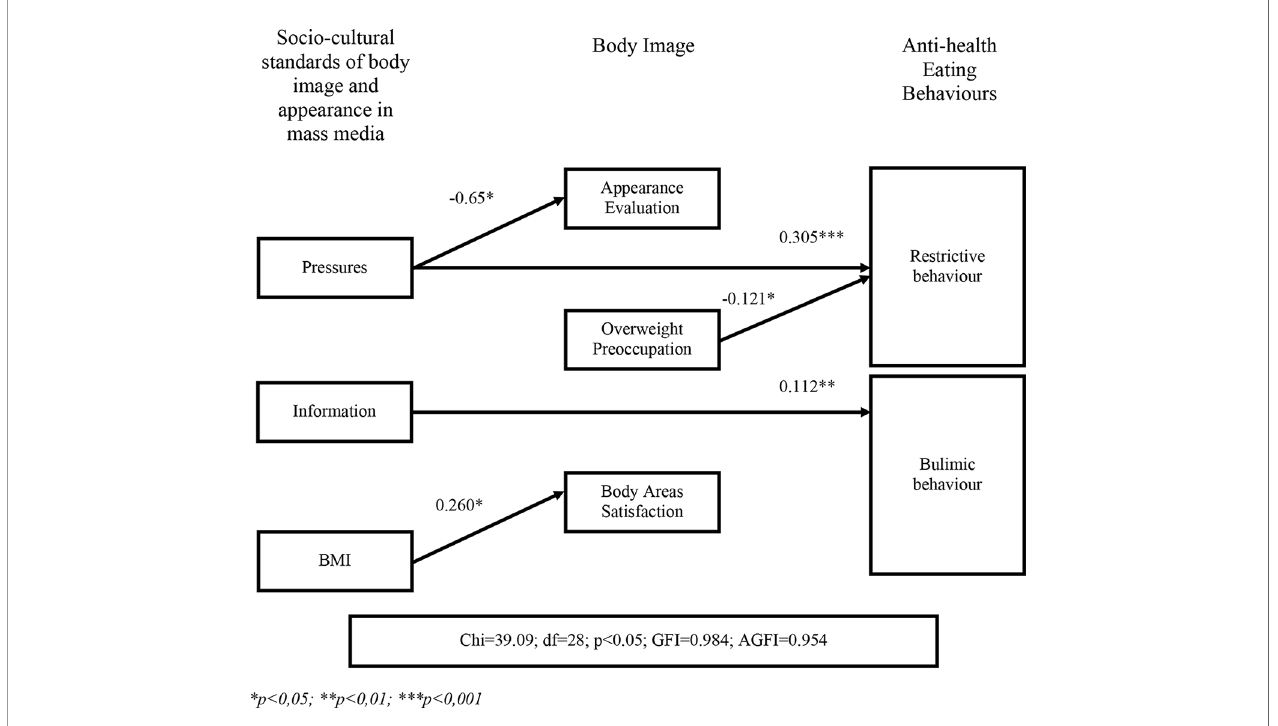
FIGURE 2 | Analysis of path model for studied variables in a group of women.